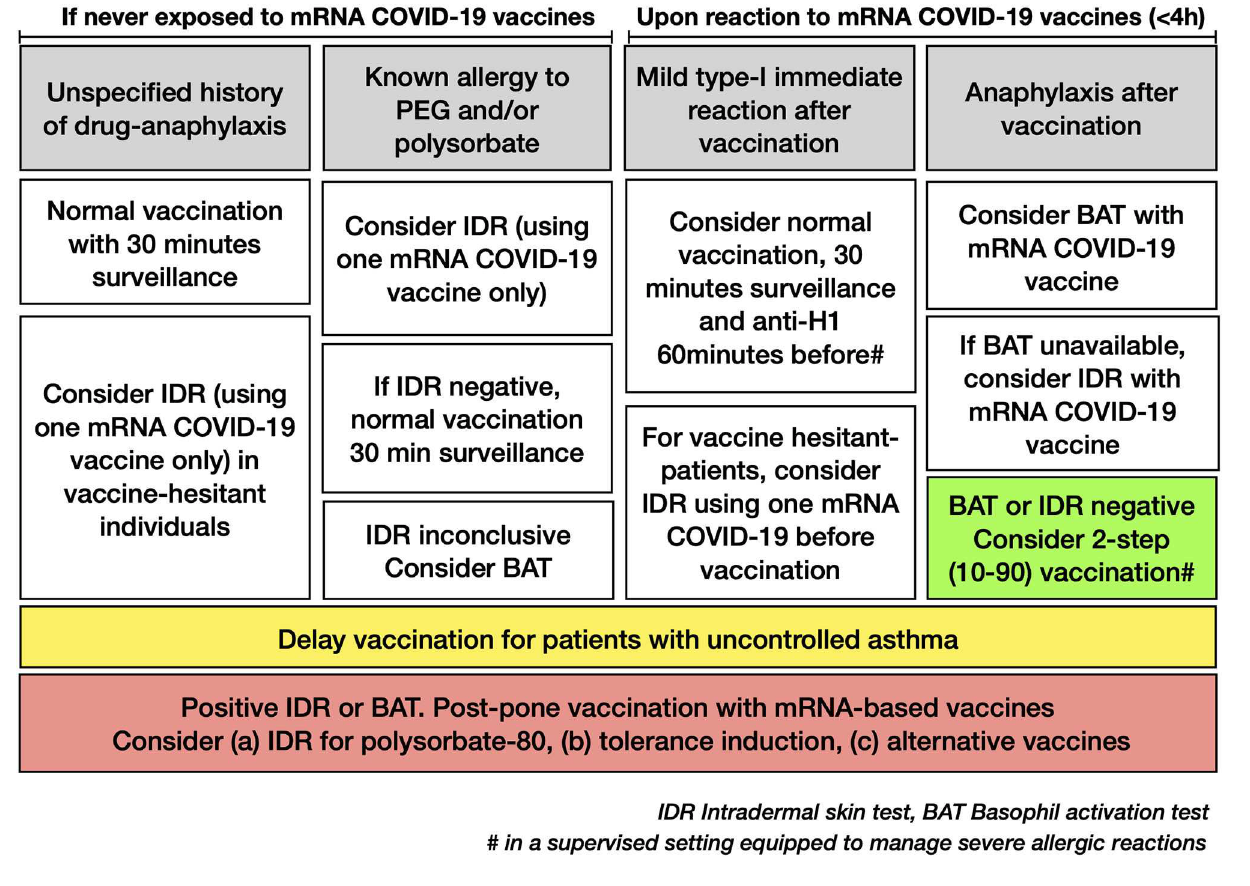
FIGURE 5 | A suggested algorithm for the management of allergic patients with possible hypersensitivity against mRNA-based COVID-19